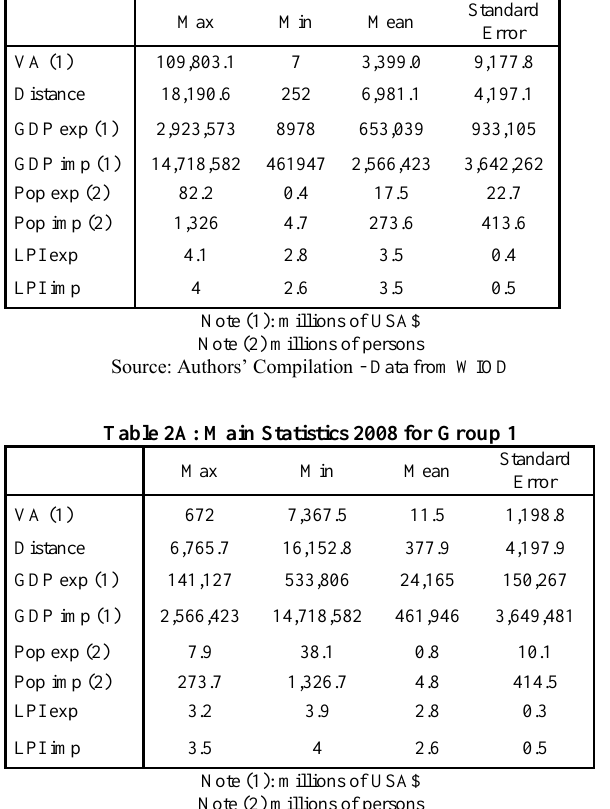
Table 1A: Main Statistics 2008 Total Sample